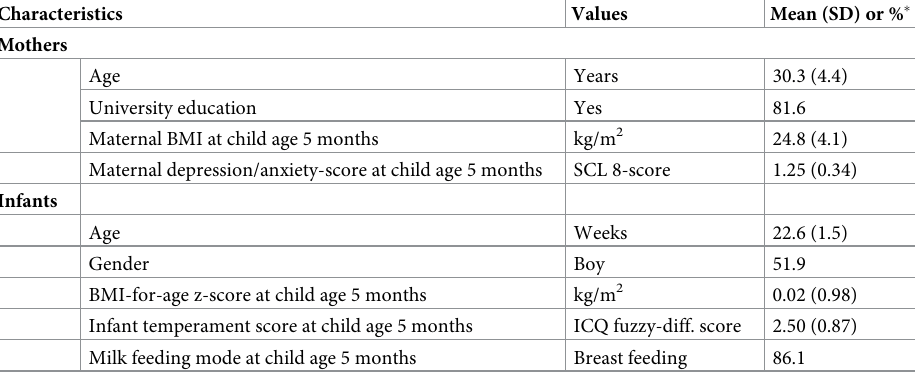
� Valid percentages for categorical variables and means with SD for continuous